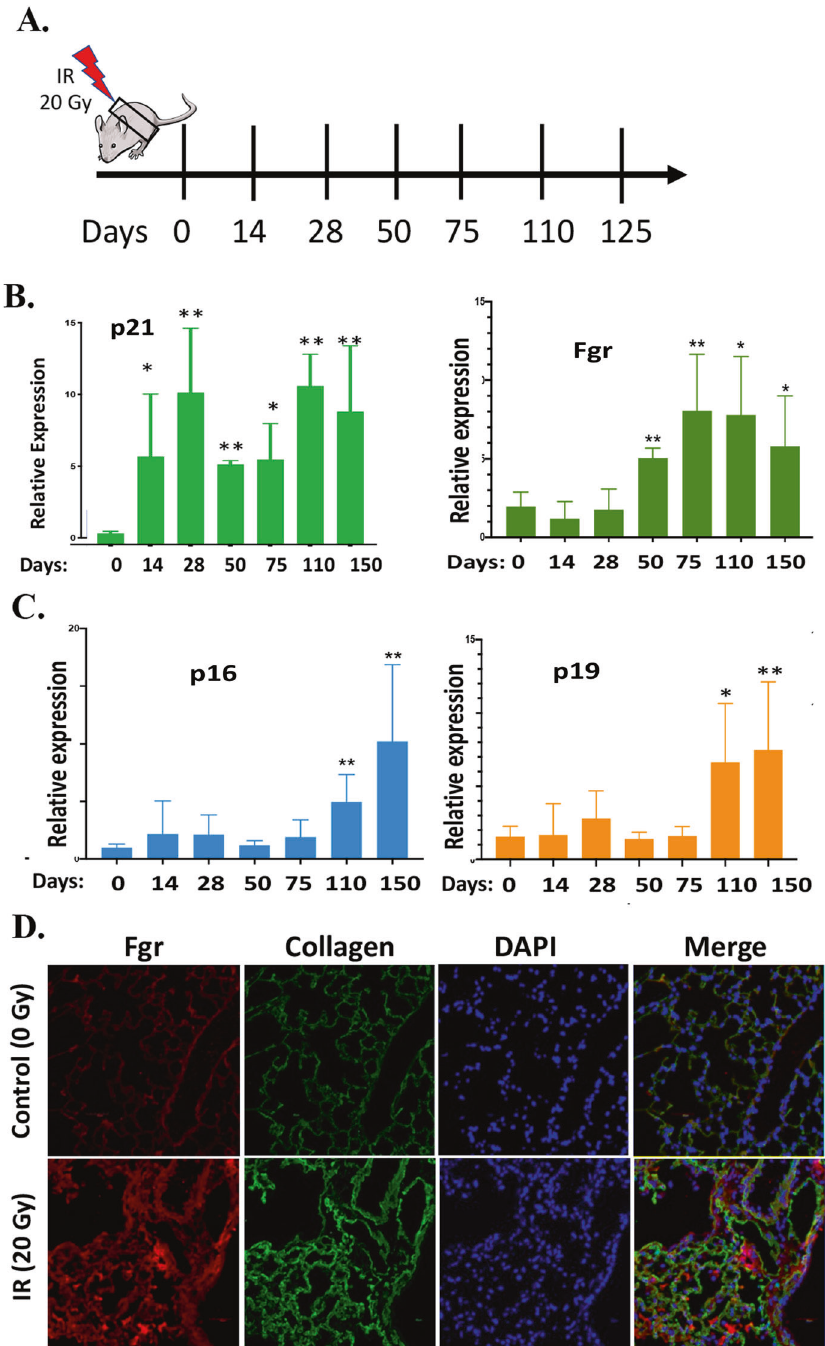
Fig. 7 Induction of Fgr and biomarkers of senescence in irradiated mouse lungs. A 951 Scheme showing the thoracic irradiation (20 Gy) and the days the lungs of the C57BL/6 mice 952 were harvested for total RNA. B Expression of p21 and Fgr in the mouse lungs were evaluated 953 by RT-qPCR at different days. C Expression of p16 and p19 in the mouse lungs was evaluated by RT-qPCR at different days. D 20 Gy irradiated mouse lungs tissue was immunostained using Fgr and Collagen antibodies ( n = 3 − 5 mice, * P = <0.05; ** P = 0.01), P values were calculated by ANOVA